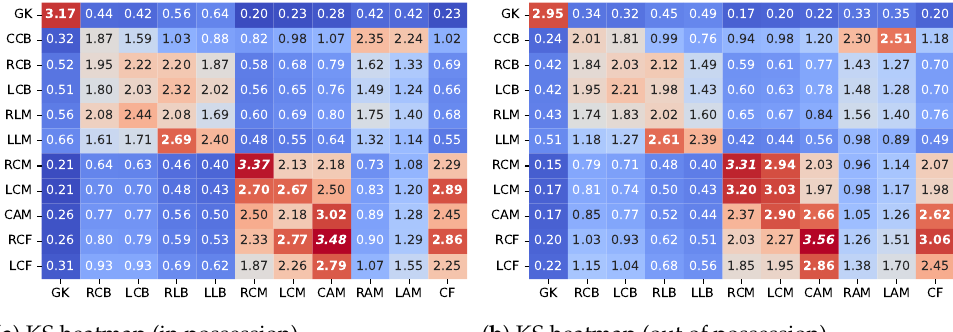
( a ) KS heatmap (in possession). ( b ) KS heatmap (out of possession). Figure 4. Comparison of the VA of players’ roles in both team